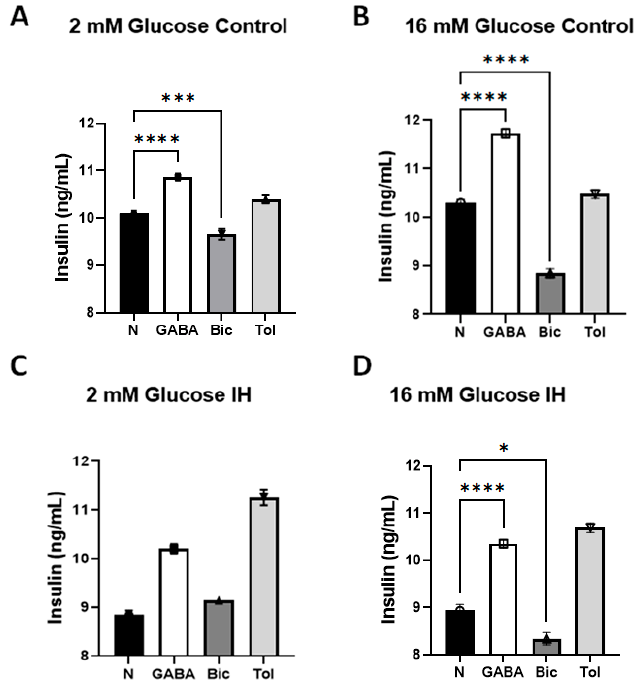
Figure 5. Changes in insulin secretion by primary islet cell groups ( n = 3) responding to GABA and bicuculline (Bic) quantified by ELISA assays. ( A ) In 2 mM glucose media, the insulin secretion levels by the control islets increased with exogenous addition of GABA, and decreased with bicuculine. ( B ) In 16 mM glucose media, the insulin secretion levels by control islets increased with exogenous addition of GABA, and decreased with bicuculine. ( C ) No comparisons differed significantly, except for normal (N) versus 10 mM Tolbutamide (Tol) ( p = 0.0448). ( D ) In 16 mM glucose medium for IH- treated islets, secretion increased with exogenous addition of GABA and decreased with bicuculine. * indicates p < 0.05, *** indicates p < 0.001 and **** indicates p < 0.0001. Comparisons between N vs. Tol were not indicated here; however, the addition of Tol elevated the insulin levels significantly at p < 0.05 when compared with each baseline N in each panel, except for ( B ) ( p =